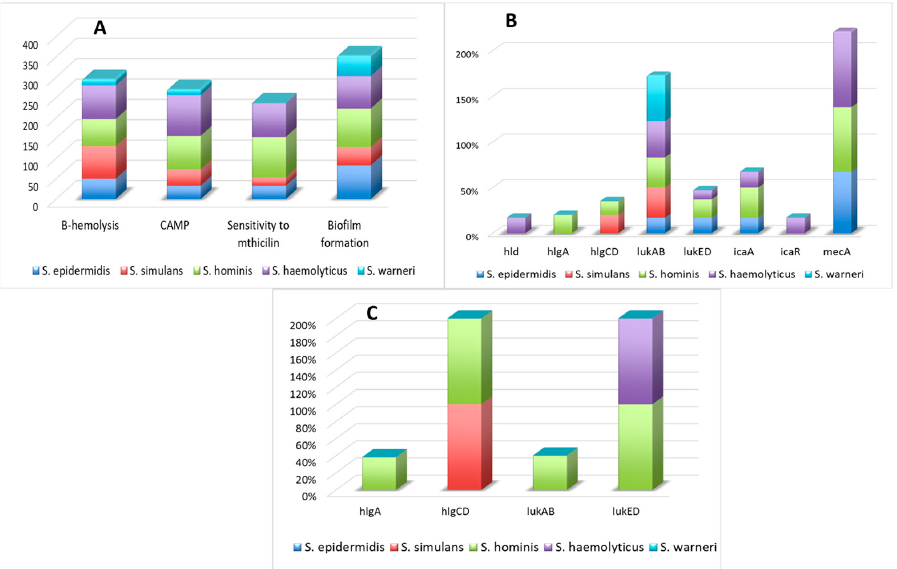
Figure 1. The presence of virulence factors that are homologous to S. aureus was tested phenotypically ( A ) and genotypically ( B ). Figure ( C ) presents the expression of detected genes. Most S. h a emolyticus and S. simulans isolates indicted h a emolytic activity on agar plates supplemented with sheep blood and gave a positive result of the CAMP, which